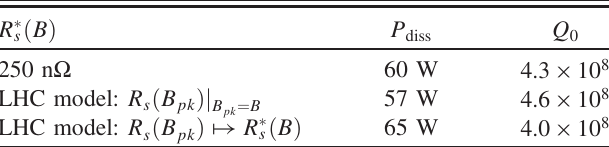
TABLE II. rf power loss of the WOWCC at V ⊥ ¼ 3 MV using different field dependent surface resistances.